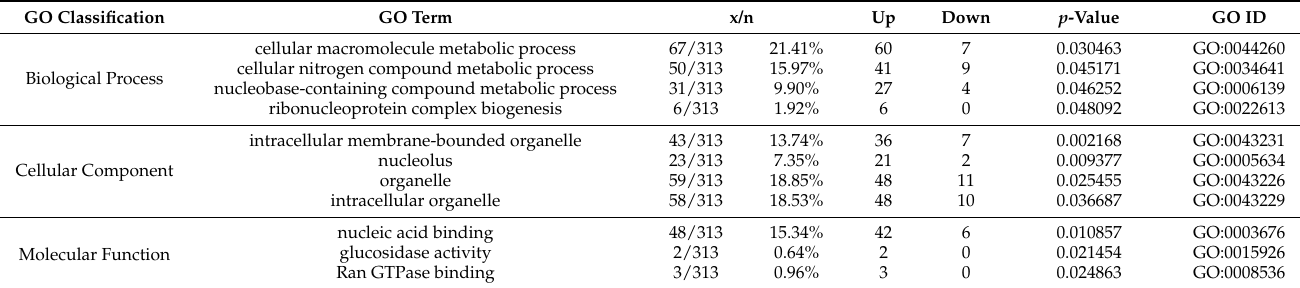
Table 6. Significant enrichment of GO of DEPs of (MG-T vs.